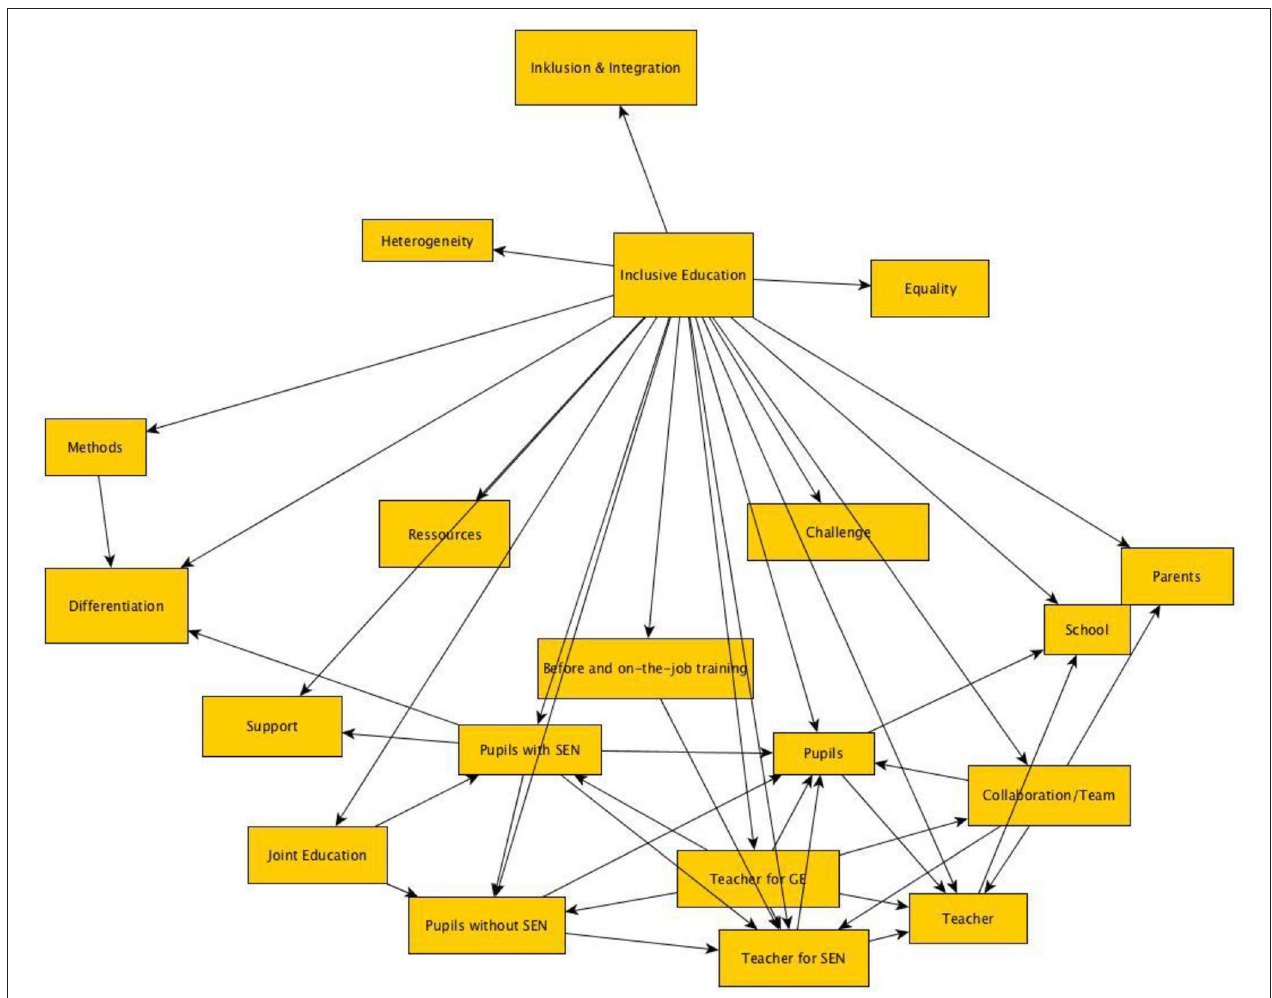
FIGURE 3 | Pathfinder network of participants in multi-professional teams at t2 ( N =